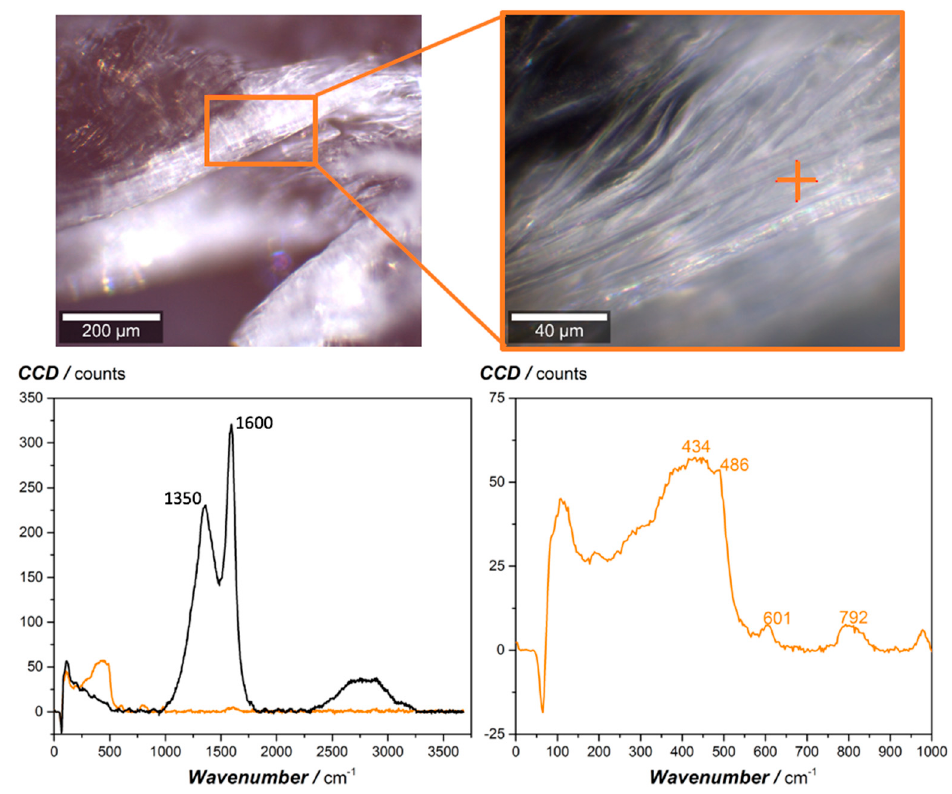
Figure 5. Optical microscopy images of the residual cone calorimeter char of the sample with 2.3 vol.% SiO 2 with lower and higher magnification and the corresponding Raman spectrum taken at the dense, white appearing layer on top of the burning zone (orange spectrum, measurement position indicated by orange cross in higher magnified microscopy image). The black Raman spectrum was recorded from the inside (opposite side of the burning zone) of the cone colorimeter sample.